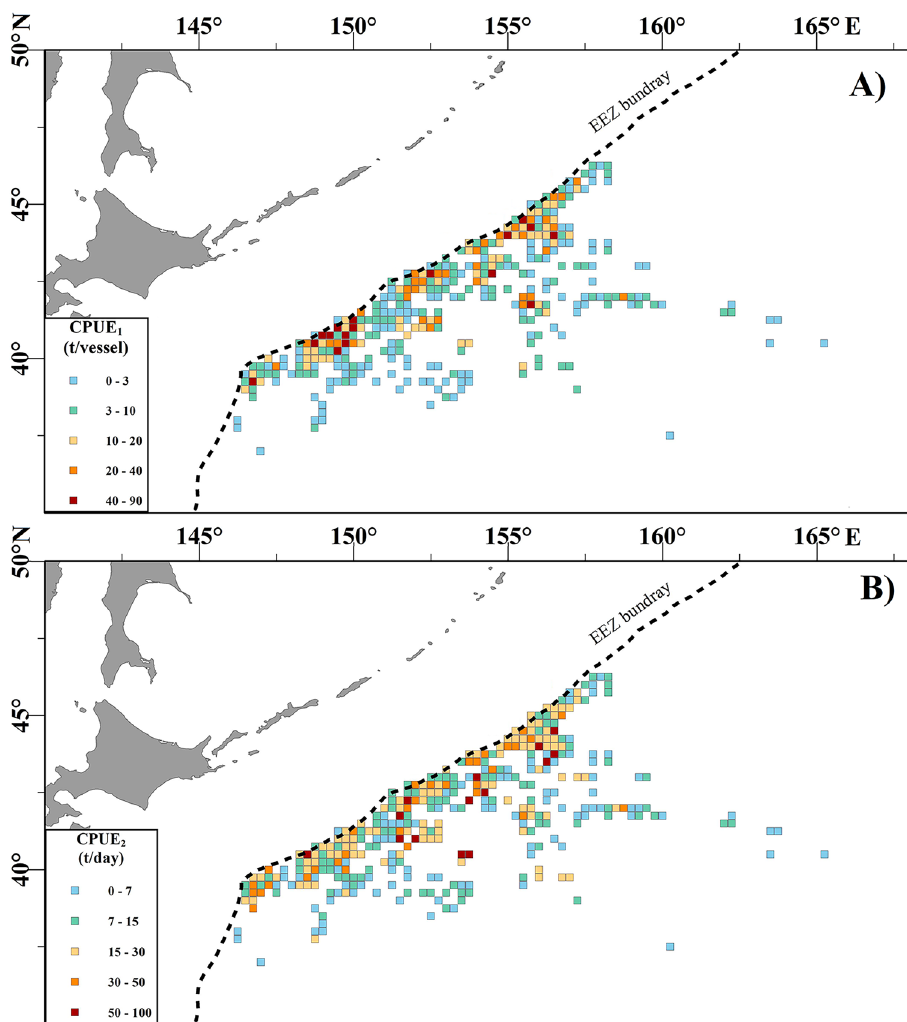
Figure 2. Spatial distributions of ( A ) annual average CPUE 1 and ( B ) CPUE 2 for Pacific saury of Chinese stick- held dip net fishing vessels in the northwestern Pacific Ocean in 2014–2017. The black dotted line is the EEZ boundary. Maps were created using ArcGIS 10.2 sofware by Esri (www. arcgis.